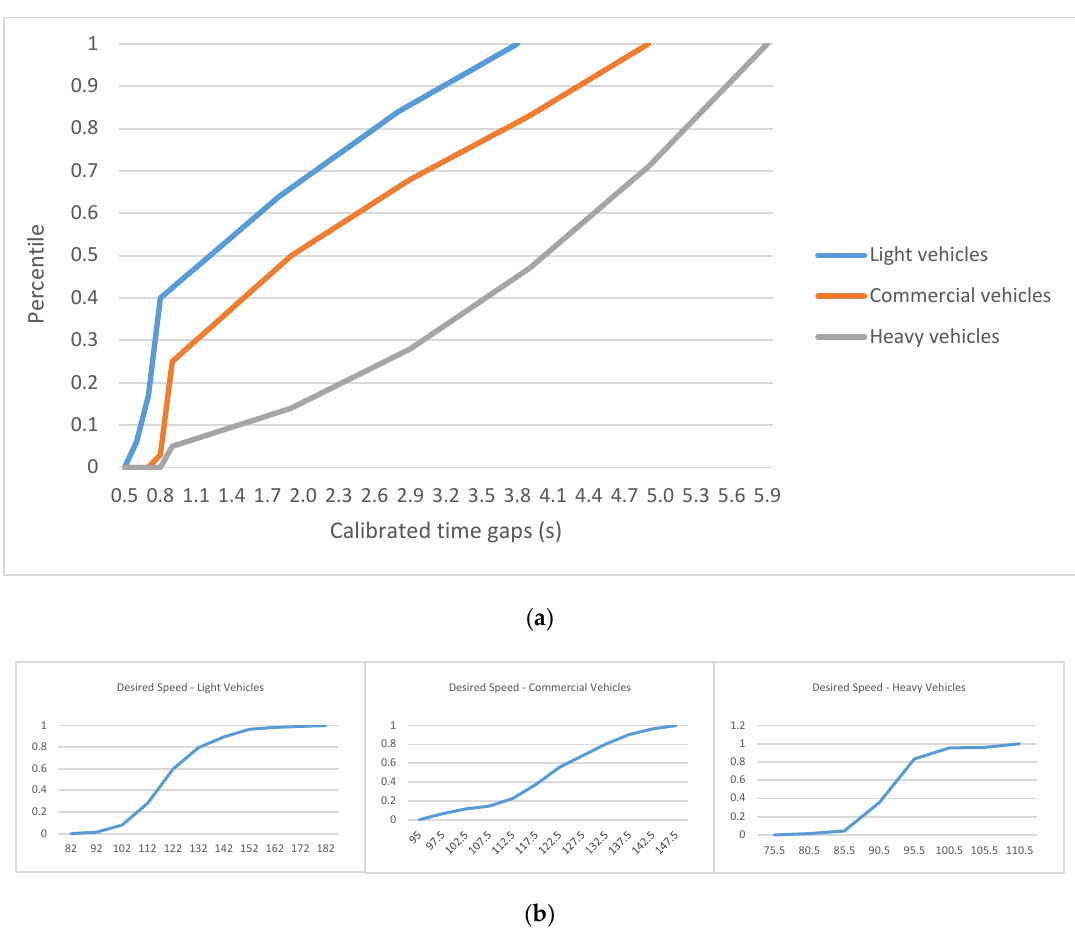
Figure 7. Calibrated time gap distributions ( a ) and calibrated desired speeds ( x -axis: km/h; y -axis: percentile) ( b ). Table 3. Lateral behavioral parameters .